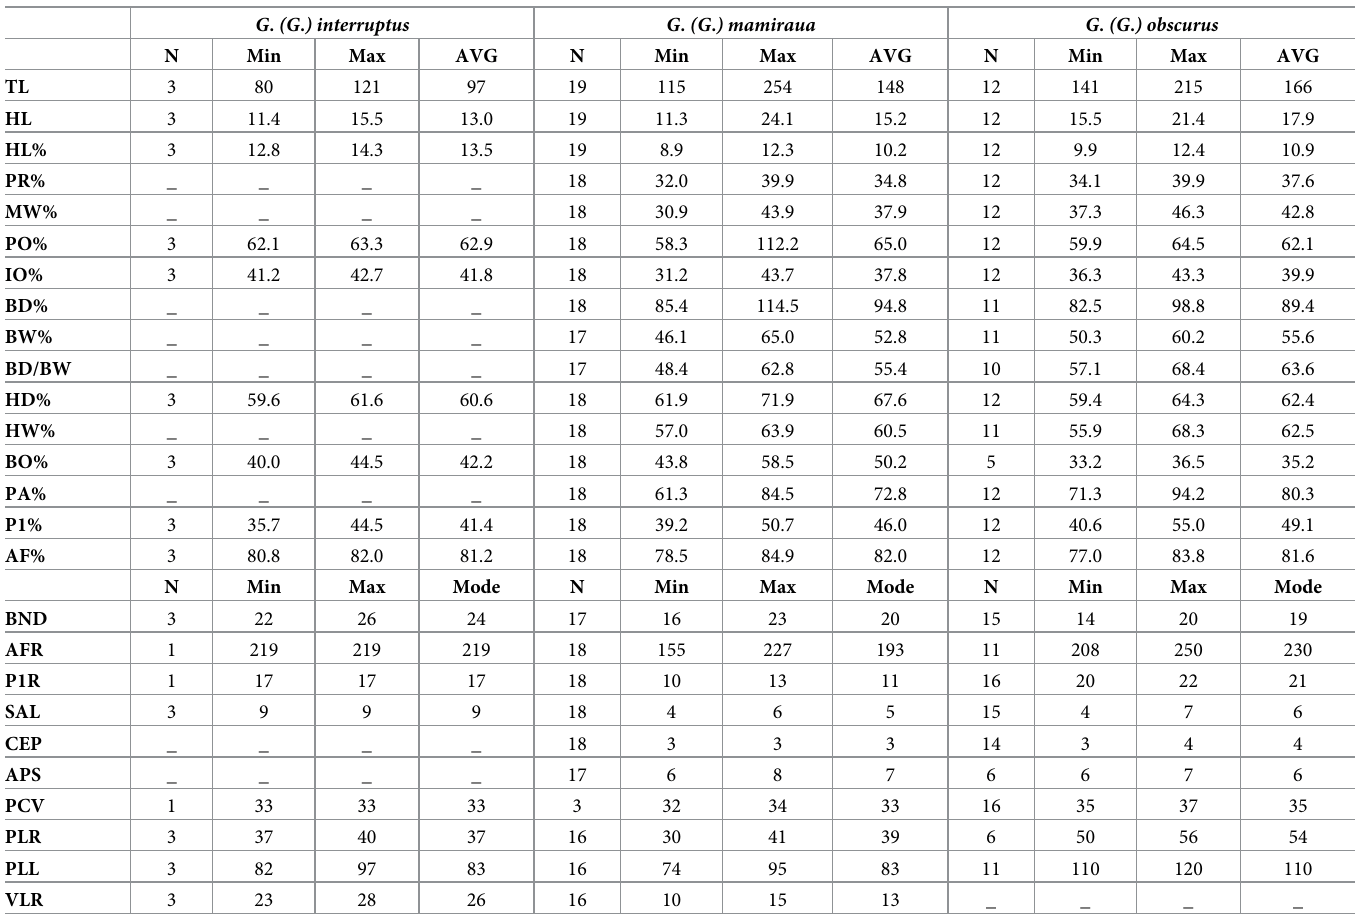
Table 10. Summary of morphometric and meristic data for Gymnotus (G . ) interruptus , G . (G . ) mamiraua and G . (G . ) obscurus . G . (G . )